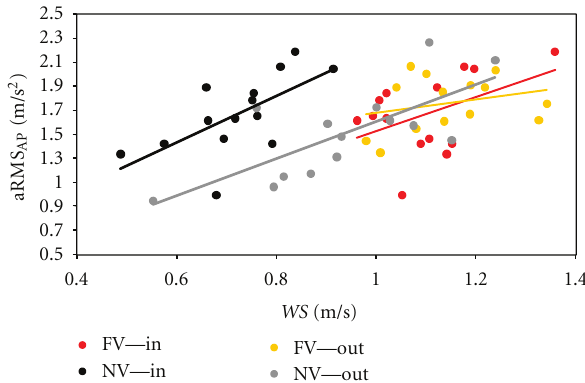
Figure 2: E ff ects of vision and environment on the relation between gait stability and speed. Values of antero-posterior acceleration root mean square are shown for all subjects in respect to their walking speed (together with the relevant regression lines) in the two visual conditions (FV versus NV) and the two environments (in versus out).